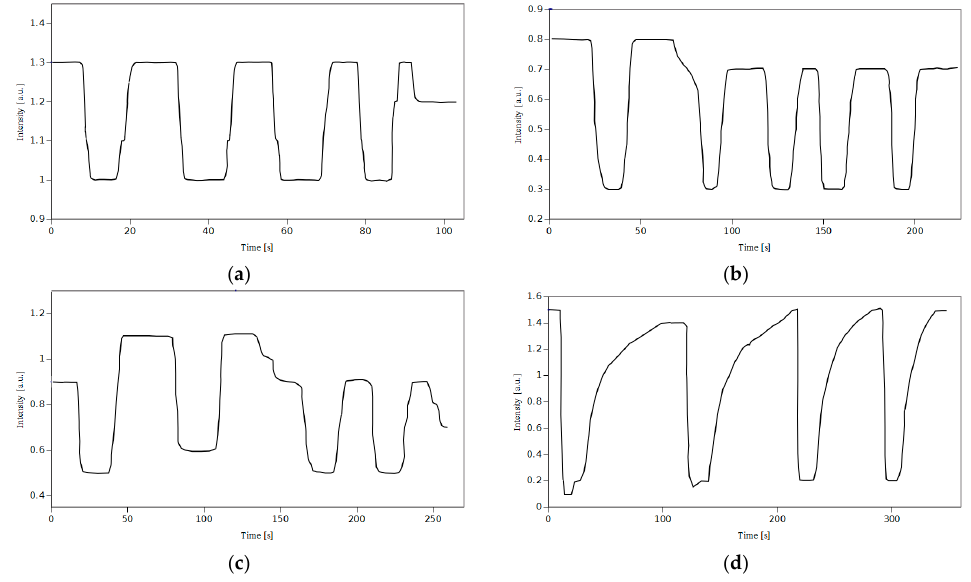
Figure 8. Response time characteristics for four different sensing layer thicknesses, 0.75 μ m, 3 μ m, 3.5 μ m and 9 μ m (( a ), ( b ), ( c ), ( d ) respectively).